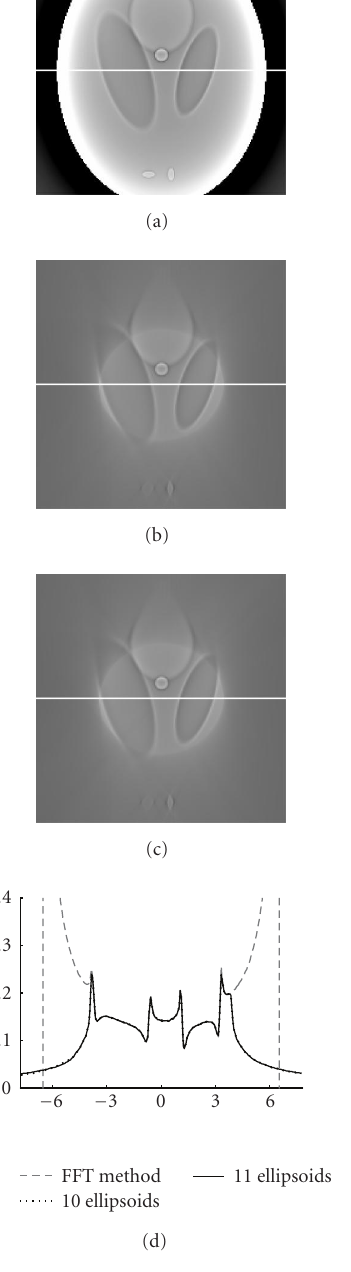
Figure 6: Reconstructed LT images assuming a 15cm length de- tector with a display window [ − 0 . 3,0 . 5]. (a) The ground truth re- constructed using the FFT directly from the ideal phantom slice, (b) and (c) the LT images reconstructed from the data without and with the 11th ellipsoid outside the scanning locus, respectively, and (d) representative profiles along the white lines in (a), (b), and (c).